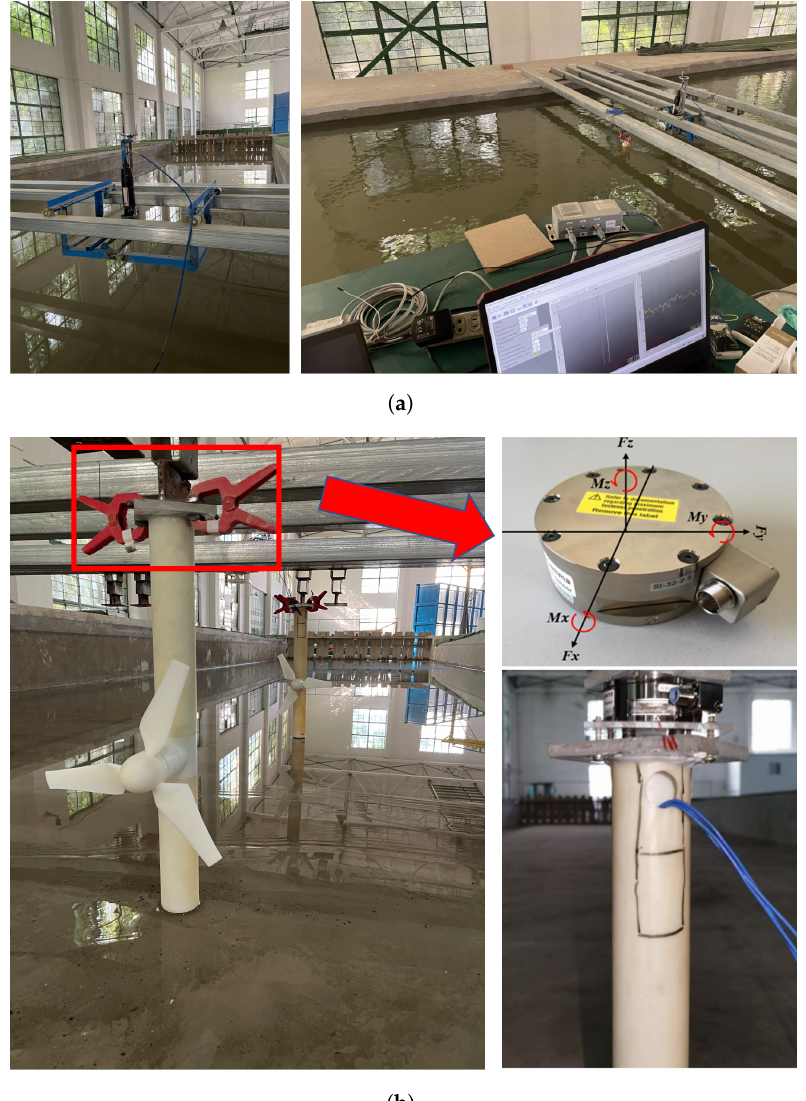
Figure 2. The measurement devices, as positioned in the flume at Hohai University. ( a ) The downward-facing Nortek Vectrino Profiler is positioned on a movable platform. ( b ) The ATI-gamma six-axis force–torque